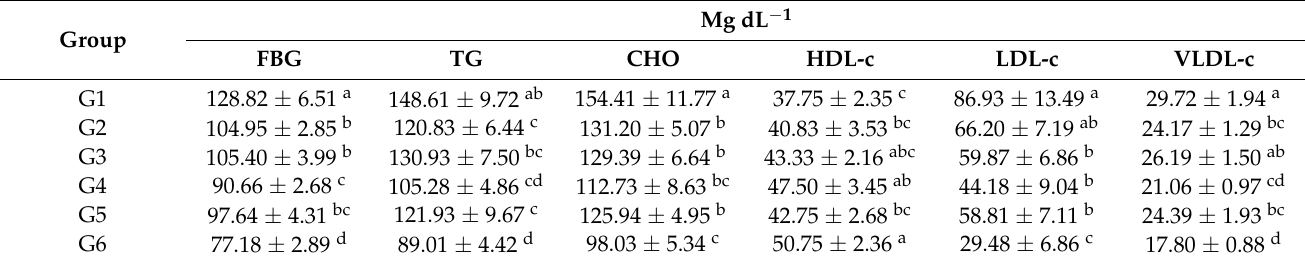
Table 3. Effect of FCM, FCM-D, and intermittent on lipid profile (md dL − 1 ) in obese rats fed a high-fat diet for 6 weeks, n =